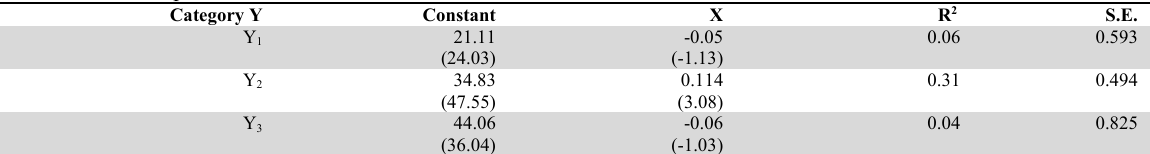
The results of R-Square values